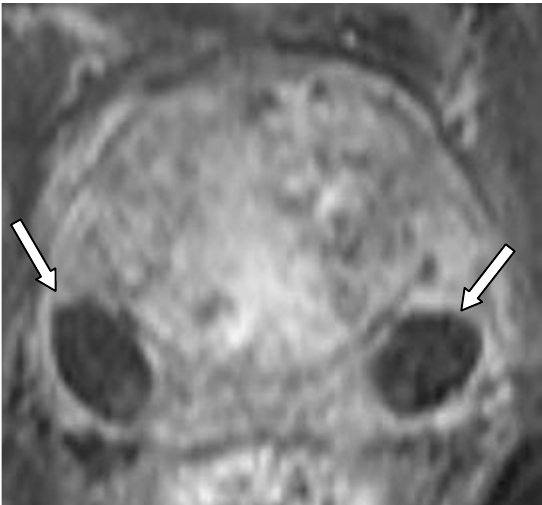
FIGURE 3. Axial T1, postgadolinium-enhanced MRI of the prostate after focal treatment. The dark, low-signal areas (indicated by arrows) demonstrate lack of perfusion in the zone of treatment. (Courtesy of Doug Pendsé, MD, Hashim Uddim Ahmed, MD, and Mark Emberton,